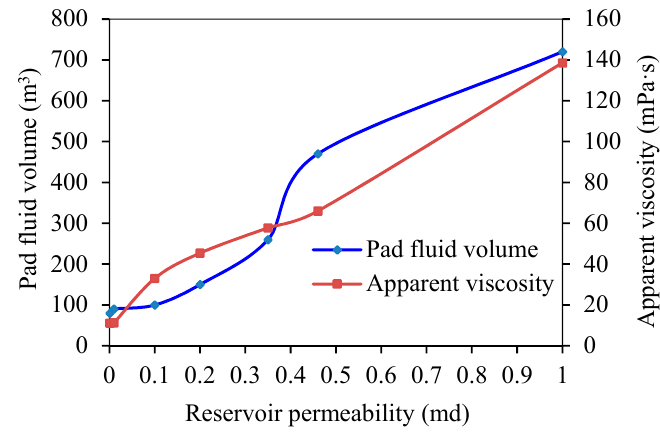
Figure 14. Optimized pad fluid volume and fluid’s apparent viscosity vs. reservoir permeability.